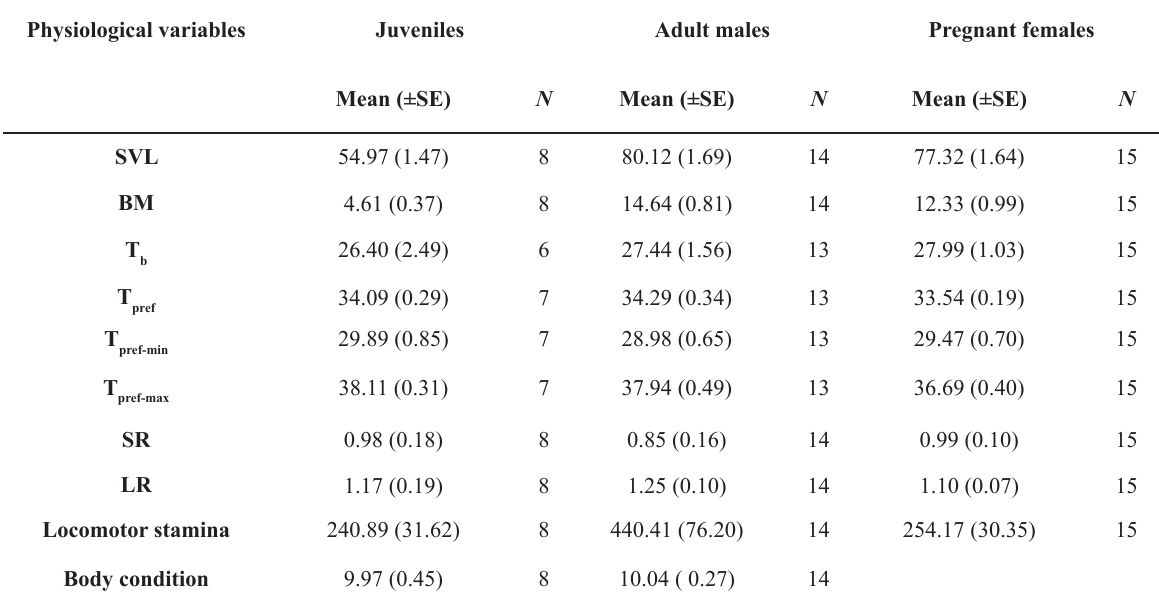
Mean (± standard error) or median (when data did not have a normal distribution), and sample size ( N ) of physiological variables measured for Liolaemus sarmientoi : snout-vent length (SLV, mm), body mass (BM, g), body temperature (T ºC), preferred body temperature (T ; °C), minimum preferred body temperature (T pref ; °C), short run (SR; m/s), long run (LR; m/s), and locomotor stamina (s) of juveniles, adult body temperature (T pref-max males, and pregnant females, and body condition index of juveniles and adult